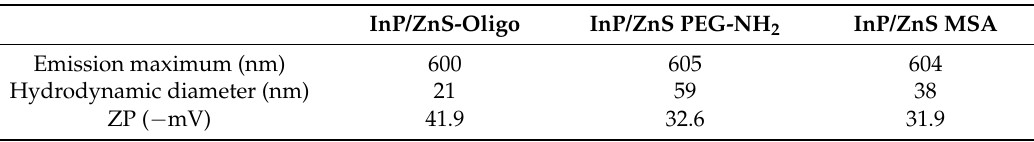
Figure 1. Transmission electron microscope images of QDs with different functionalities with size histogram (inset); ( a ) InP/ZnS- Oleylamine ( b ) InP/ZnS-PEG-NH 2 QDs ( c ) InP/ZnS-Oligo ( d ) InP/ZnS-MSA QDs. Table 1. Summary of the properties of the InP/ZnS QDs obtained using PL (photoluminescent emission), TEM and dynamic light scattering to determine QD diameter and hydrodynamic radius, respectively.